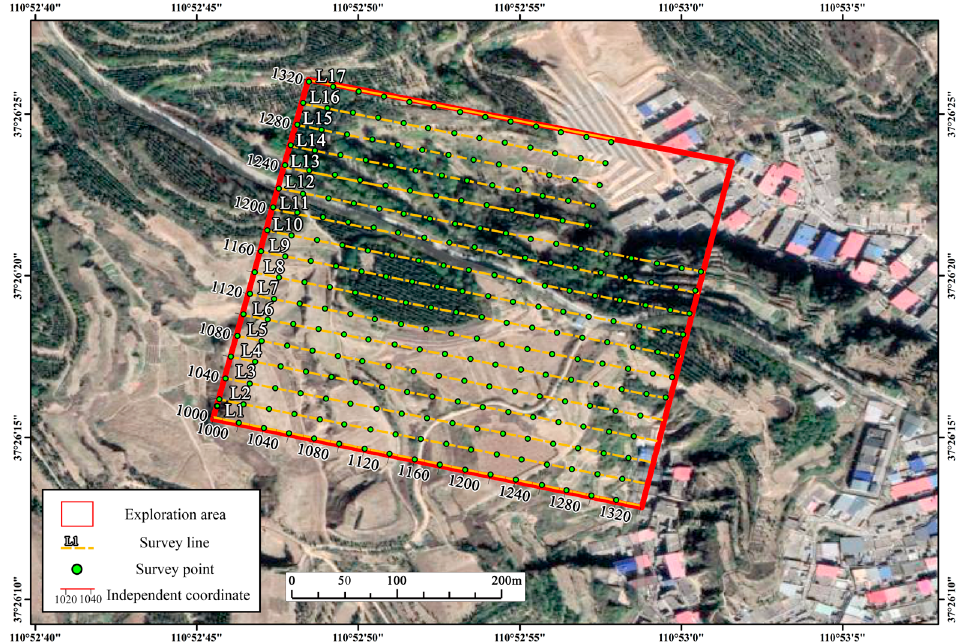
Figure 1. Geographical Location of the Study Area (image from BigMap).